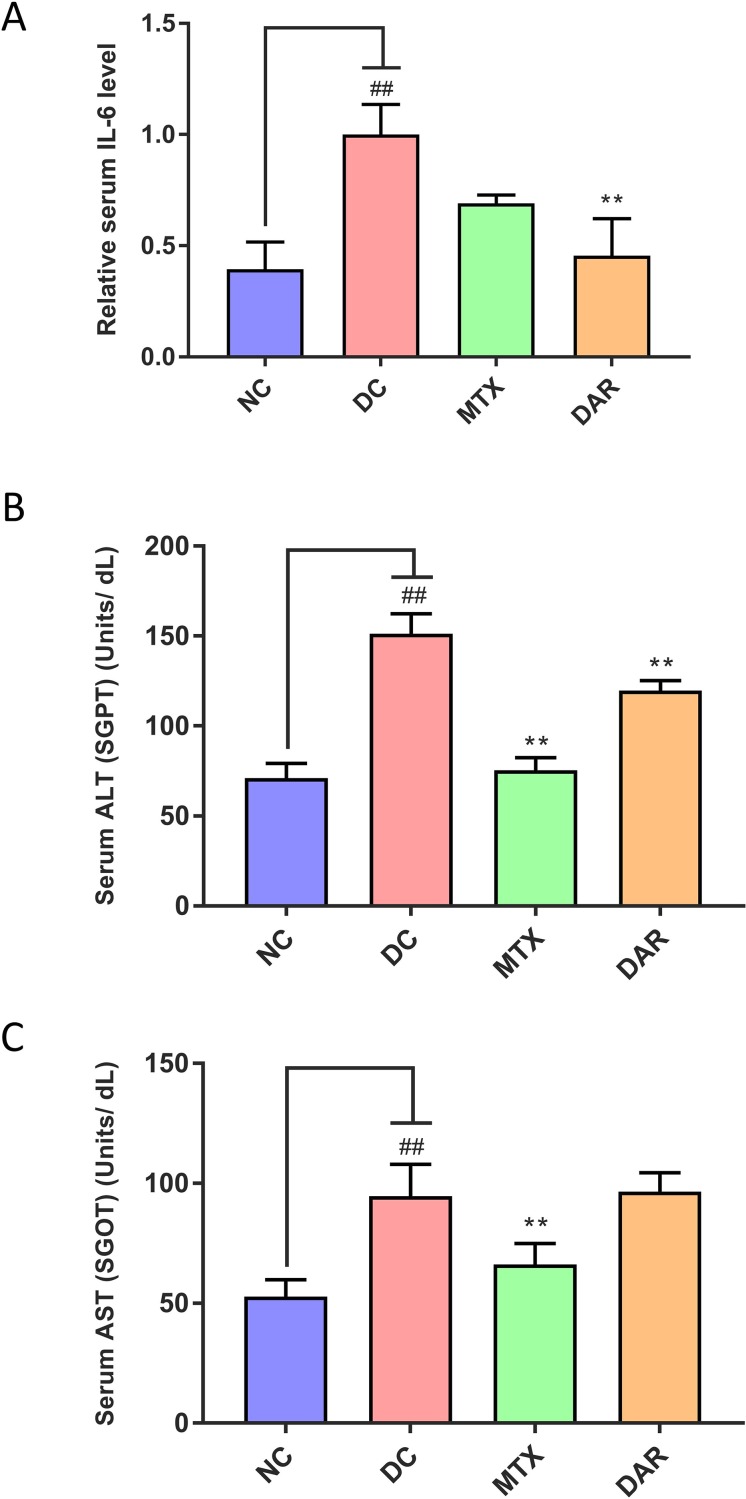
Biomarker measurement in blood serum. (A) Analysis of the serum IL-6 levels showed its induction in the collagen-antibody stimulated disease control (DC) Balb/c mice. Treatment of the collagen-antibody-induced arthritis mice with DAR and MTX led to a significant serum IL-6 inhibition as compared to the DC animals. (B) Measurement of liver enzyme alanine aminotransferase (ALT), also known as serum glutamate-pyruvate transaminase (SGPT), was done in the blood serum of the mice and showed an increase in the DC animals indicating the onset of liver damage as compared to the NC animals. Treatment of CAIA mice with DAR or MTX showed a significant reduction in the levels of ALT post-treatment. (C) Analysis of the aspartate aminotransferase (AST) also known as serum glutamic-oxaloacetic transaminase (SGOT) enzyme showed a substantial increase in the CAIA mice as compared to the NC mice. DAR treatment did not show any modulation in liver toxicity as compared to the DC animals; MTX treatment showed a significant reduction in the AST levels as compared to the DC animals. Values in the results are mean ± SEM. A one-way analysis of variance (ANOVA) followed by Dunnett’s multiple comparison t-test was used to calculate the statistical difference. Student’s unpaired t-test was used to calculate the statistical difference in comparison to MTX. P-value ## < 0.01 and ** < 0.01.